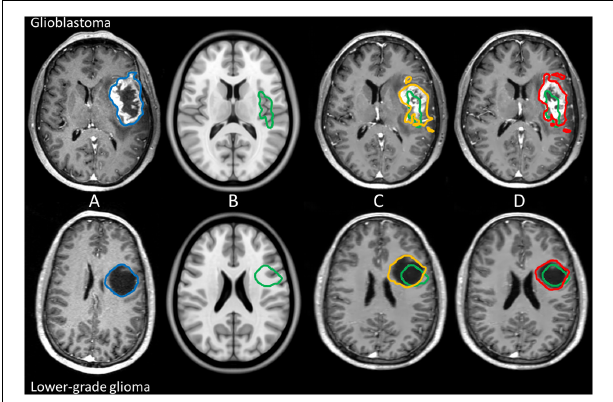
FIGURE 1 | Example of manual tumor annotations followed by pre-operative linear and non-linear registration for glioblastoma and lower-grade glioma in the left hemisphere. Manual segmentation of tumor in patient space is shown in blue, the corresponding estimated target volume in anatomical reference space in green, the tumor segmentation after linear transformation in orange, and the tumor segmentation after non-linear transformation in red. The top row shows imaging of a glioblastoma patient, and the bottom row shows imaging of a lower-grade glioma patient. From left to right: patient space (A) , anatomical reference space (B) , patient space linearly transformed to anatomical reference space (C) , and patient space non-linearly transformed to anatomical reference space (D) .